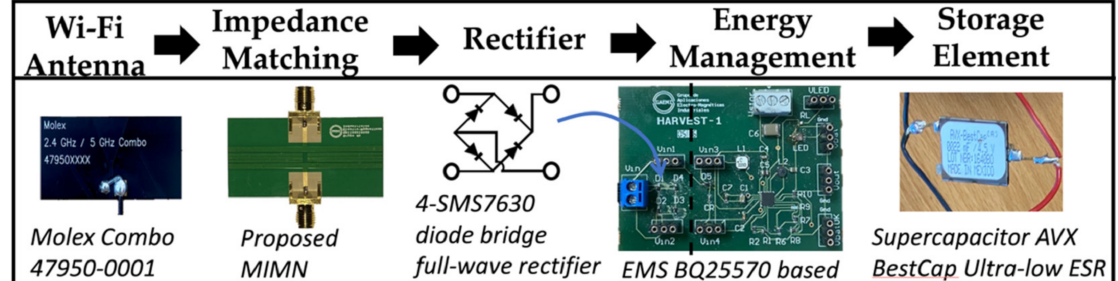
Figure 5. Components used to implement the different functional blocks of the RF-EH prototype. From left to right: Planar Wi-Fi antenna Combo 47950-0001 by Molex [24]; proposed MIMN; full wave bridge rectifier using SMS7630-061 Schottky diodes [25], included in the Harvest-1 PCB; EMS based on the BQ25570 nano power boost charger and bust converter by